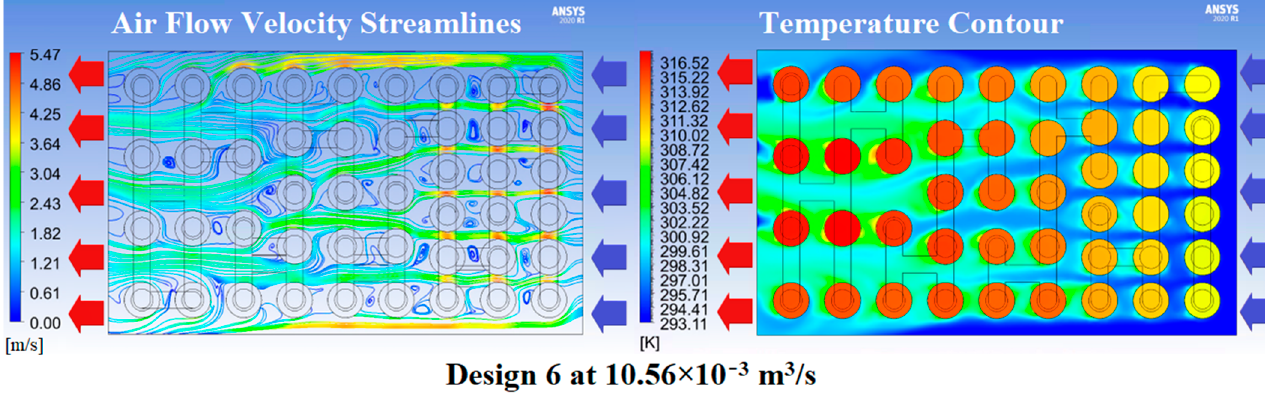
Figure 9. Air flow velocity streamlines and temperature contour of Design 6 at 10.56 × 10 − 3 m 3 /s.